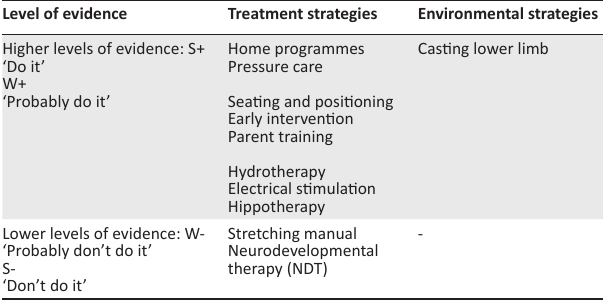
TABLE 5: Treatment and environmental strategies as reported by participants as beneficial for children’s pain management based on Novak et al.’s (2013) levels of the evidence of interventions for children with cerebral